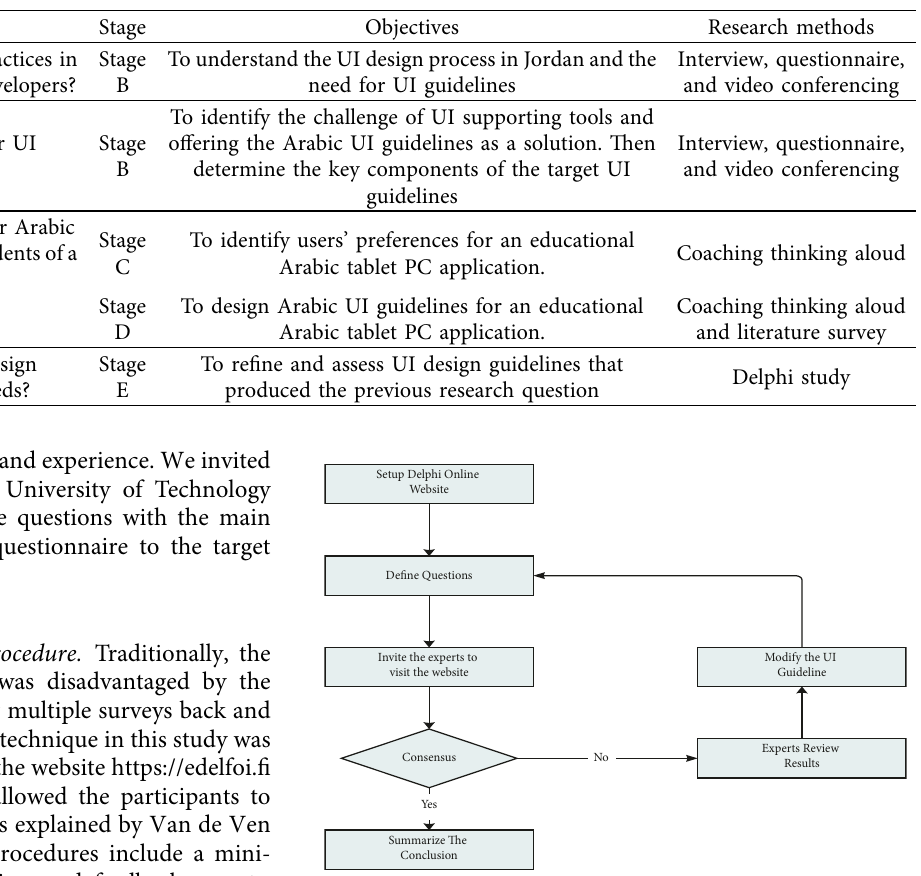
Table 1: Research design.